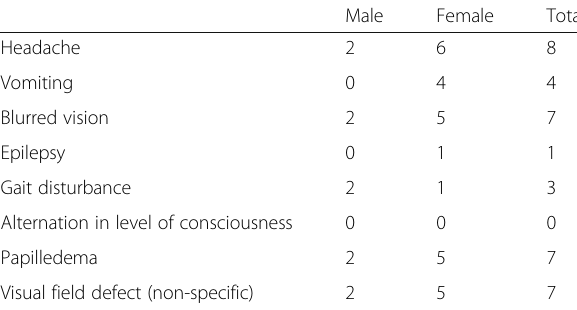
Table 1 Frequencies of different symptoms and signs on presentation